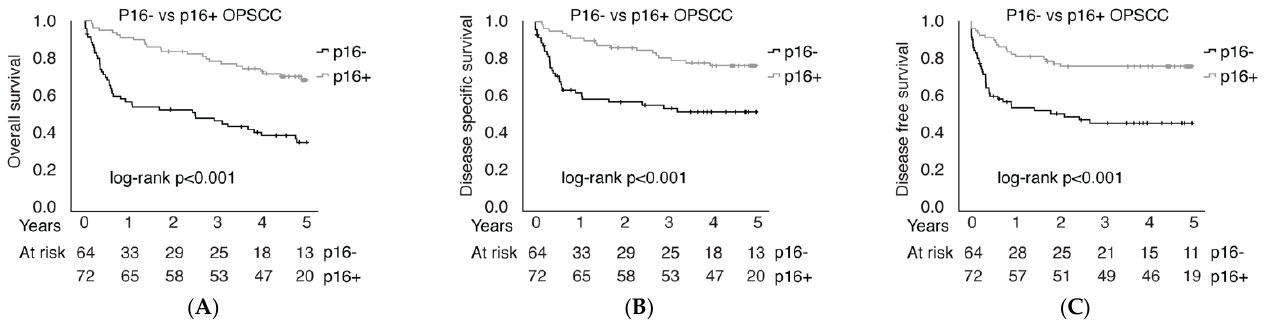
Figure 8. Overall survival ( A ), disease-specific survival ( B ) and disease-free survival ( C ) comparison between p16 − and p16+ in